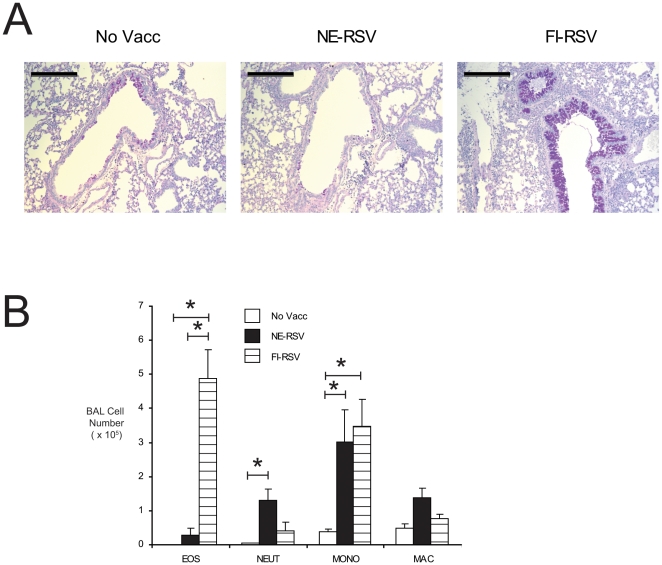
Severe histopathology is associated with formalin-inactivated RSV (FI-RSV) vaccination, but not NE-RSV.Mice were vaccinated with NE-RSV or FI-RSV, as described, and challenged with live RSV. (A) Representative lung histology (Periodic Acid Schiff's, PAS) from unvaccinated control, NE-RSV vaccinated, and FI-RSV vaccinated mice at day 8 post-infection. In (B), the absolute number of eosinophils (Eos), neutrophils (NEUT), small mononuclear cells (MONO), and macrophages (MAC) in the BALs of unvaccinated, NE-RSV vaccinated, and FI-RSV vaccinated mice at day 8 post-infection were determined via hemocytometer and differential staining. * = p<0.05, as assessed by ANOVA followed by Tukey's multiple comparison test. All other pairwise comparisons were not statistically significant.